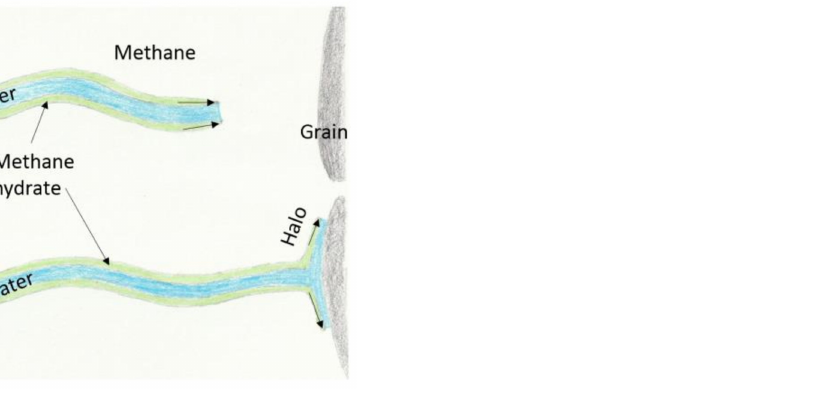
Figure 14. Proposed mechanism of the hydrate filament growth process (Figure 4). The filament is hollow and conveys water to its expanding tip ( top ), until its hits ( bottom ) the sand surface at the right and forms a halo radiating around the contact